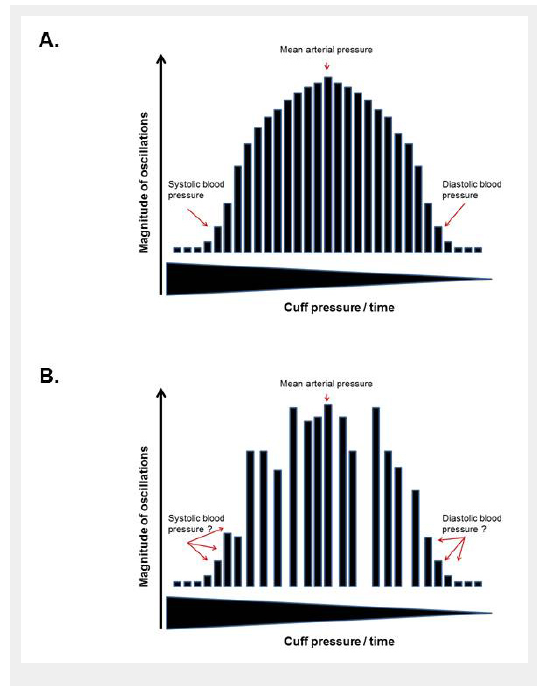
Oscillometric blood pressure measurement (technical principle). A Decreasing cuff pressure allows continuous increase of blood flow with consecutive increase in oscillation amplitude. When reaching mean arterial BP, amplitude of oscillations decreases. Estimation of systolic and diastolic BP depends on algorithms designed by the manufacturer of the device. B Arrhythmia leads to changing ventricular filling with consecutively alternating pulse pressure and alternating magnitude of oscillations, rendering determination of systolic and diastolic BP difficult at the least, if not